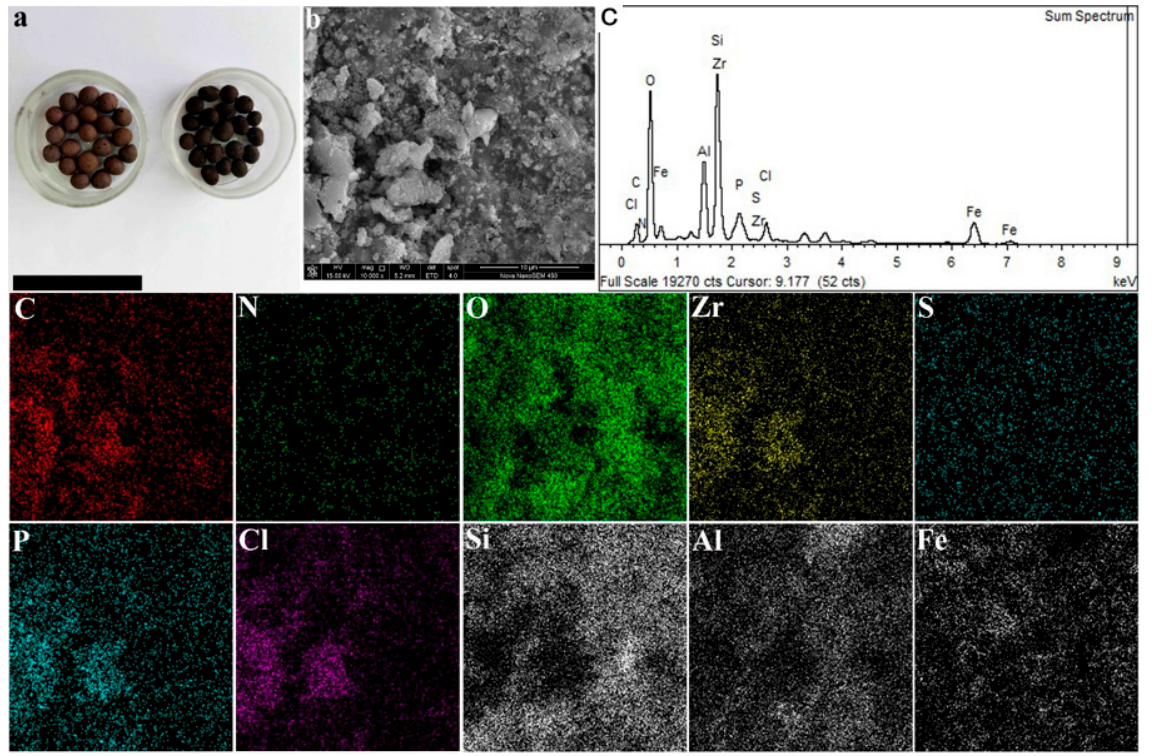
Figure 2. ( a ) Digital photo images of ceramsite before and after the immobilization of H + /BCQDs/UiO-66-NH 2 ; ( b ) SEM image and ( c ) the corresponding energy-dispersive X-ray (EDX) mappings of H + /BCQDs/UiO-66-NH 2 @ceramsite.